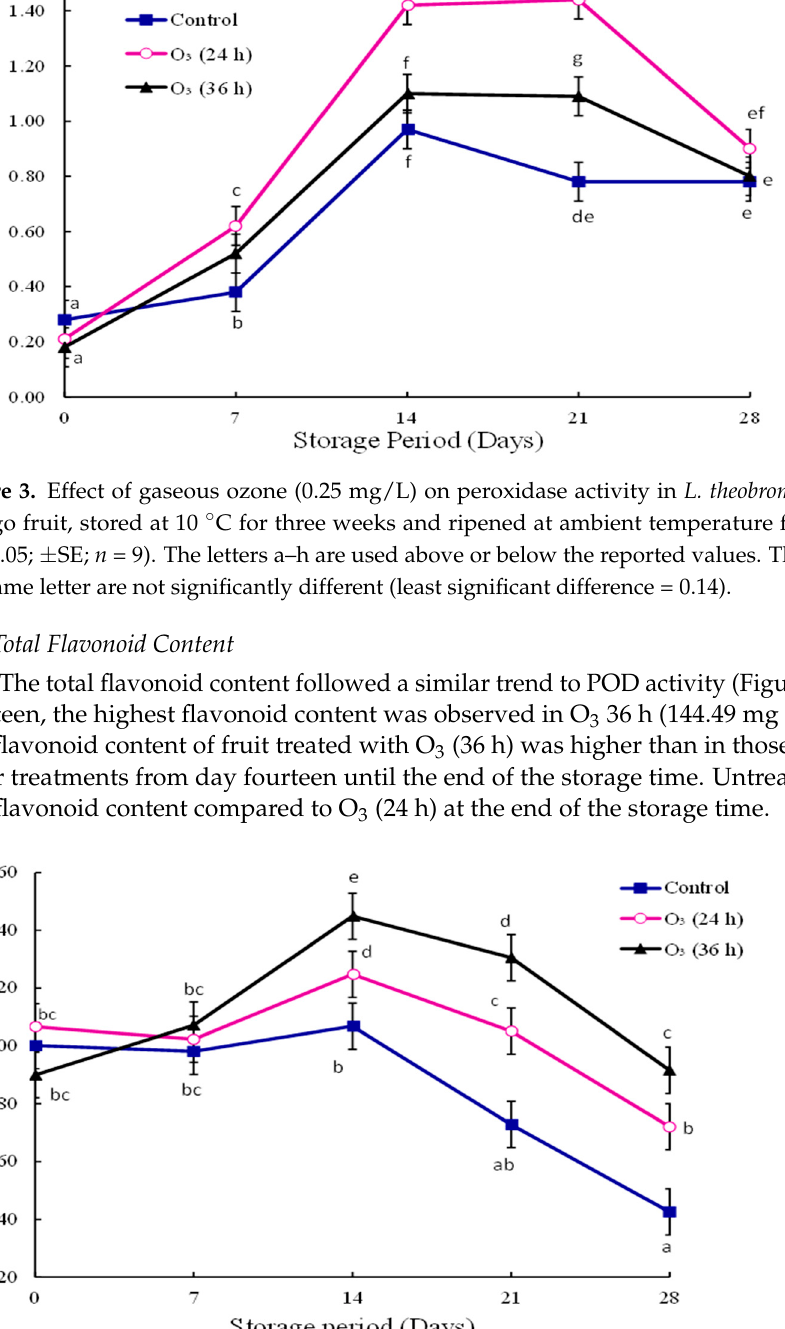
Figure 4. Effect of gaseous ozone (0.25 mg/L) on total flavonoid content of mango fruit inoculated with L. theobromae , stored at 10 °C for three weeks and ripened at ambient temperature for seven